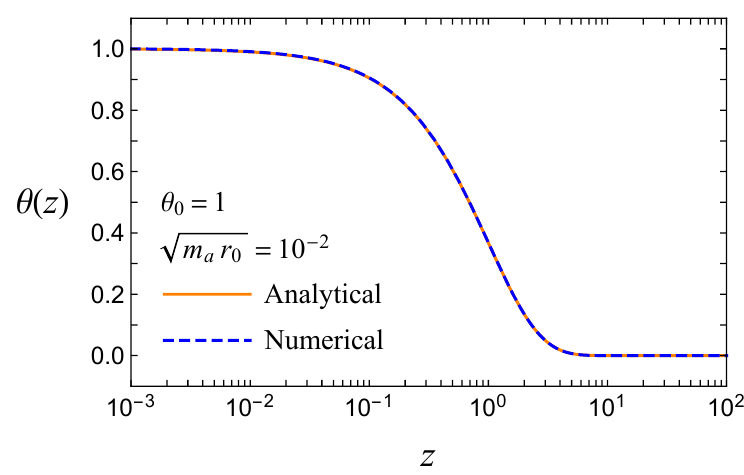
Figure 1 . The con(cid:12)guration of the axion (cid:12)eld around the monopole as a function of z = r 0 =r for p (cid:18) 0 = 1 and m a r 0 = 10 (cid:0) 2 . The monopole is located at z ! 1 (i.e. r = 0), and the axion (cid:12)eld takes the vacuum value (cid:18) 0 at z ! 0 (i.e. r ! 1 ). The core radius is assumed to be negligibly